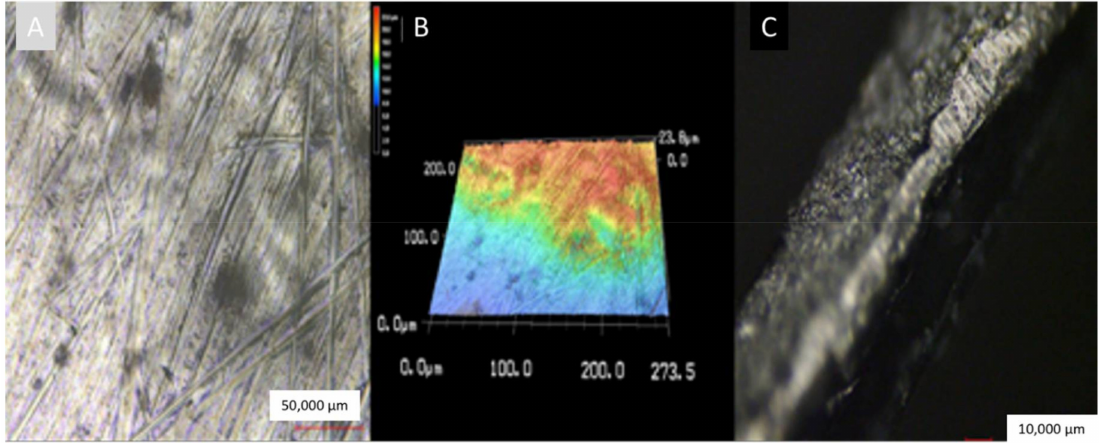
Figure 2. ( A , C ) Laser confocal image of chitosan (CS)-ZnHNTs-gentamycin sulfate (GS) coating; ( B ) 3D topography of the coated Ti